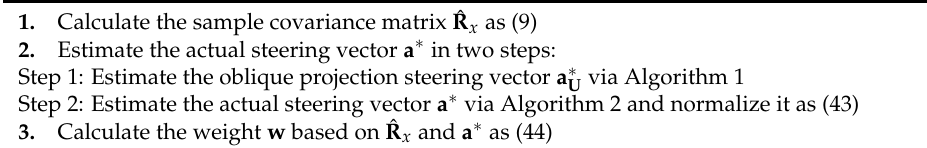
Table 1. Proposed robust Capon beamforming